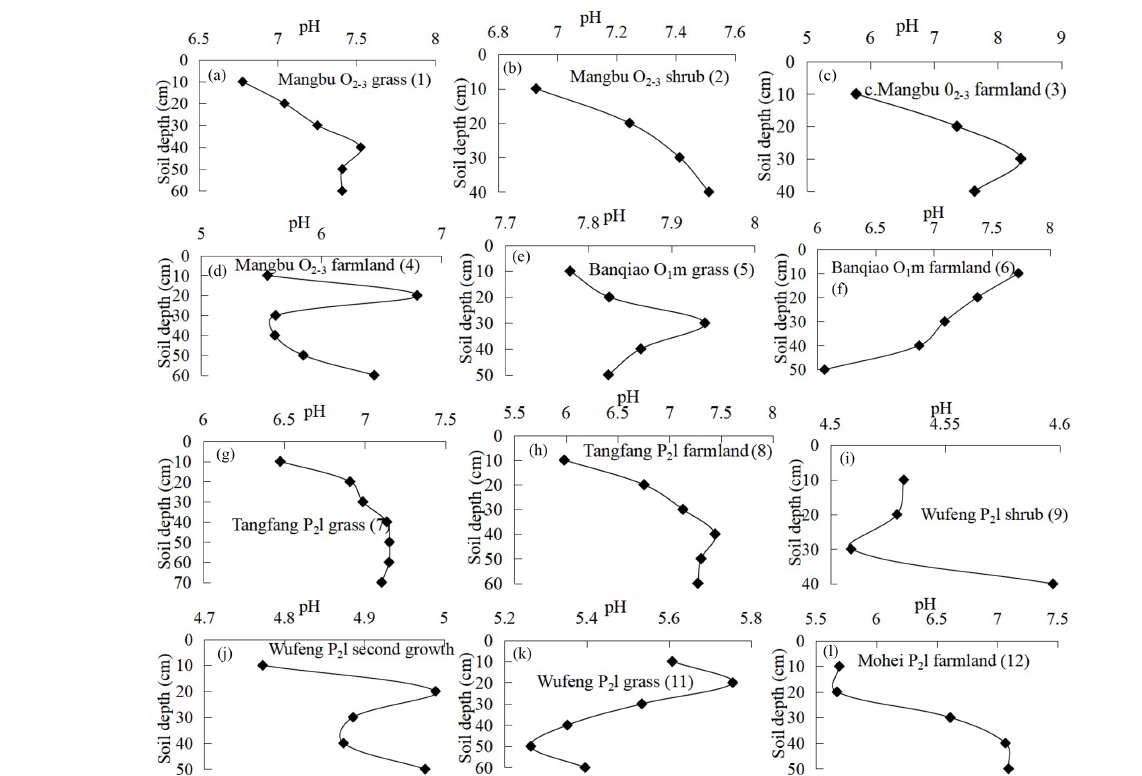
Figure 5. Soil pH of different profiles in karst area ( a–h indicate those in carbonate areas and h–l indicate those in shale areas; profile no. in brackets).